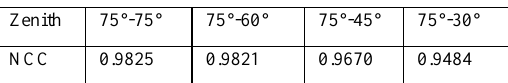
Figure 9. Sub-pixel disparity maps compared with original DEM. Table 3. NCC coefficients between disparity maps and